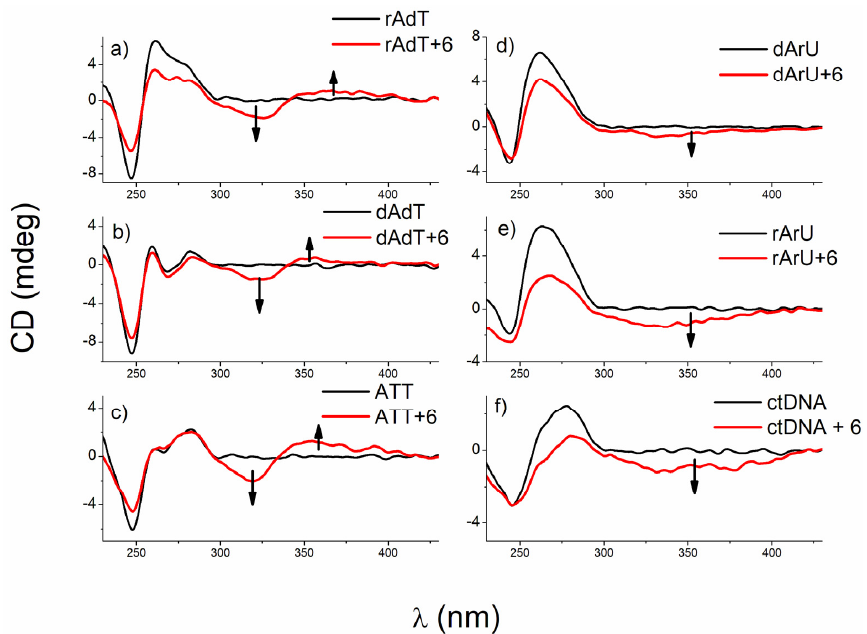
Figure 8. CD titrations of ( a ) poly rA − poly dT, ( b ) poly dA − poly dT, ( c ) ATT triplex, ( d ) poly dA − poly rU, ( e ) poly rA − poly rU, and ( f ) ctDNA ( c = 3.0 × 10 − 5 mol dm − 3 ) with 6 at molar ratios r = [compound]/[polynucleotide] = 0.3 (pH = 7.0, buffer sodium cacodylate, I = 0.05 mol dm − 3 + 1 mM EDTA for all titrations except poly dA − poly rU ( I = 0.2 mol dm − 3 + 1 mM EDTA)). At r ≤ 0.1, 6 caused either negligible or weak negative ICD signals (around 320 nm) with all polynucleotides (Supplementary Materials). However, at r > 0.1, this compound differentiates between B- and A-type helices by the mode of binding (Figure 8). Negative ICD signals support intercalation to A-type helices, poly dA − poly rU and poly rA − poly